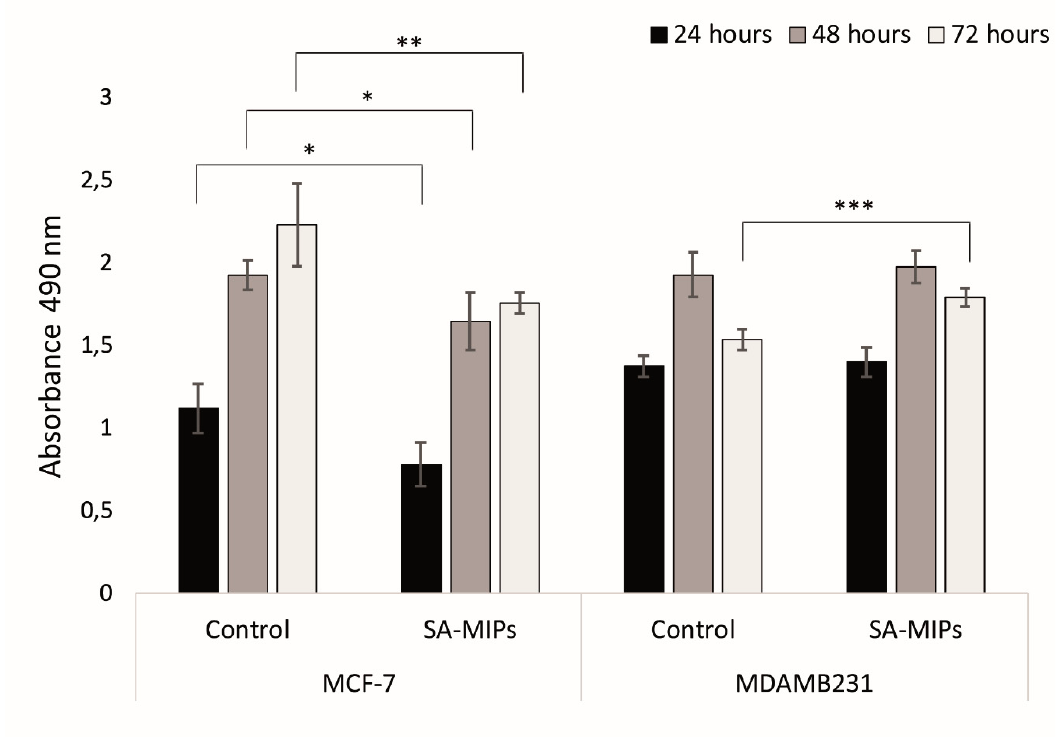
Figure 4. Cell viability assay with MCF-7 cells and MDAMB231 cells treated with 0.04 mg/mL of SA-MIPs or left as a control for three time points, 24, 48 and 72 h. The absorbance was measured at 490 nm. The results represent the mean value of five replicate wells for each condition and repeated at least twice with similar results. Statistical significance was determined with p values ≤ 0.05 *, ≤ 0.01 **, ≤ 0.001 ***.